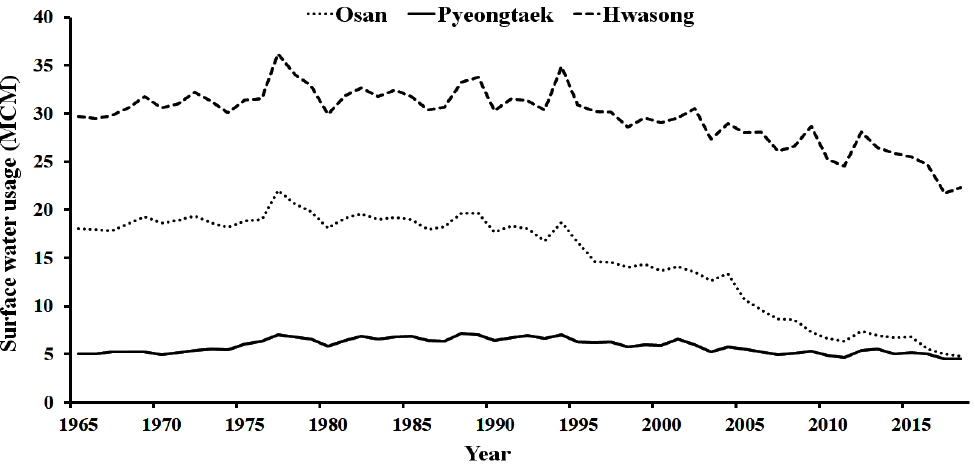
Figure 2. Yearly surface water usage in the Osan watershed.